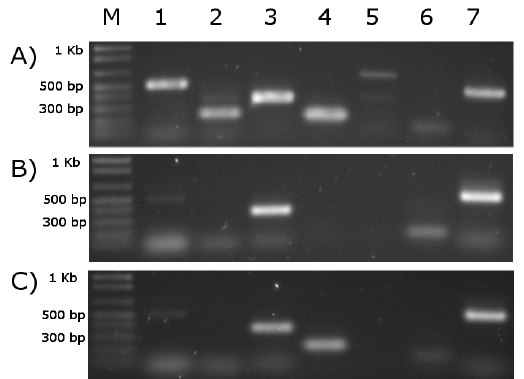
Figure 3. Reverse transcription polymerase chain reaction (RT-PCR) analysis of selected putative extracellular triacylglycerollipases from Trichoderma harzianum in medium without ( B ) or with 1% ( v / v ) olive oil ( C ) as carbon source. Lane (M) 1 Kb plus DNA Ladder (ThermoFisher, Carlsbad, CA, USA). The number of ID at genome portal of each candidate lipase corresponds to: (1) 77338; (2) 78181;